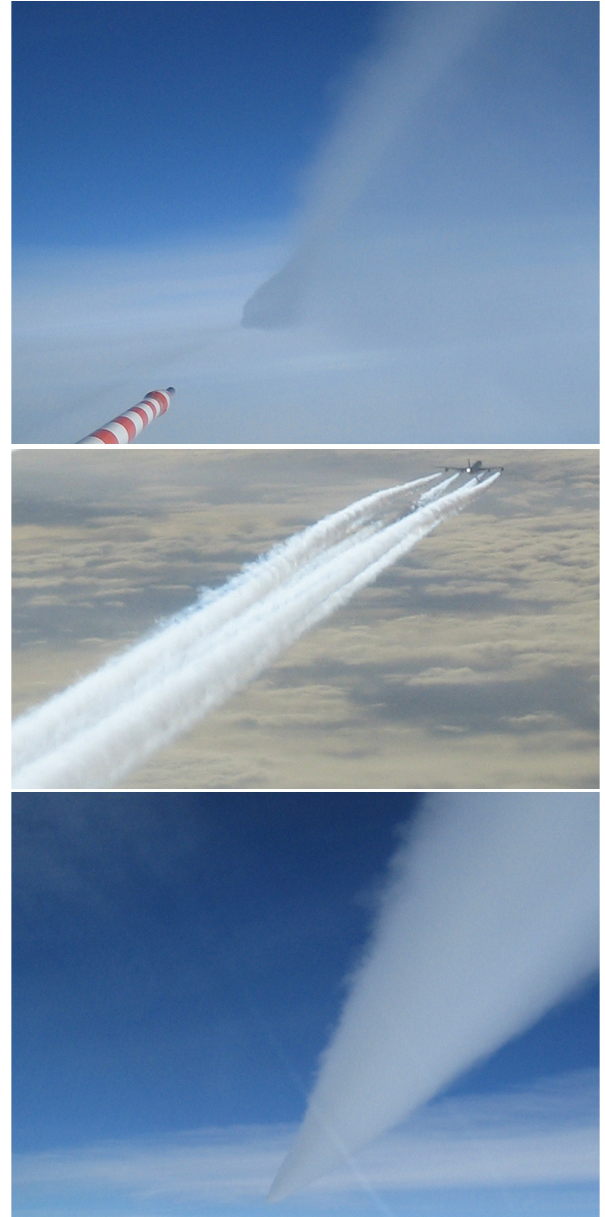
Fig. 2. Time series of contrail observations of the A319 (top), A340 (middle) and A380 (bottom) aircraft as described in Fig. 1. Particle number density n (for diameters D >2µm), extinction β , RHI, tem- perature T and flight altitude are shown. Contrail sequences used to investigate the aircraft influence on contrail properties are marked with black